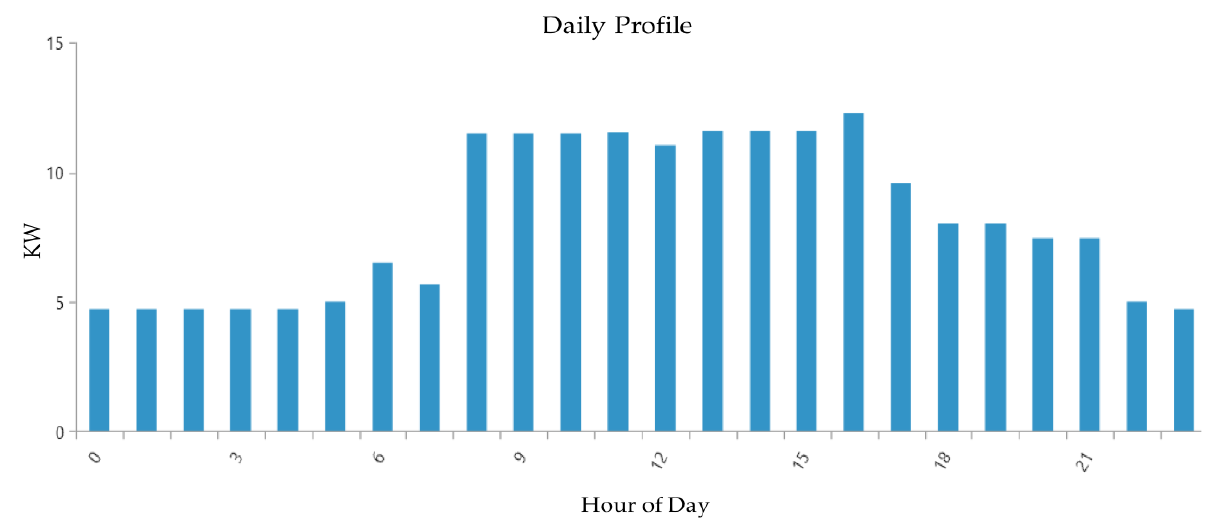
Figure 5. Daily load profile in Dubai.